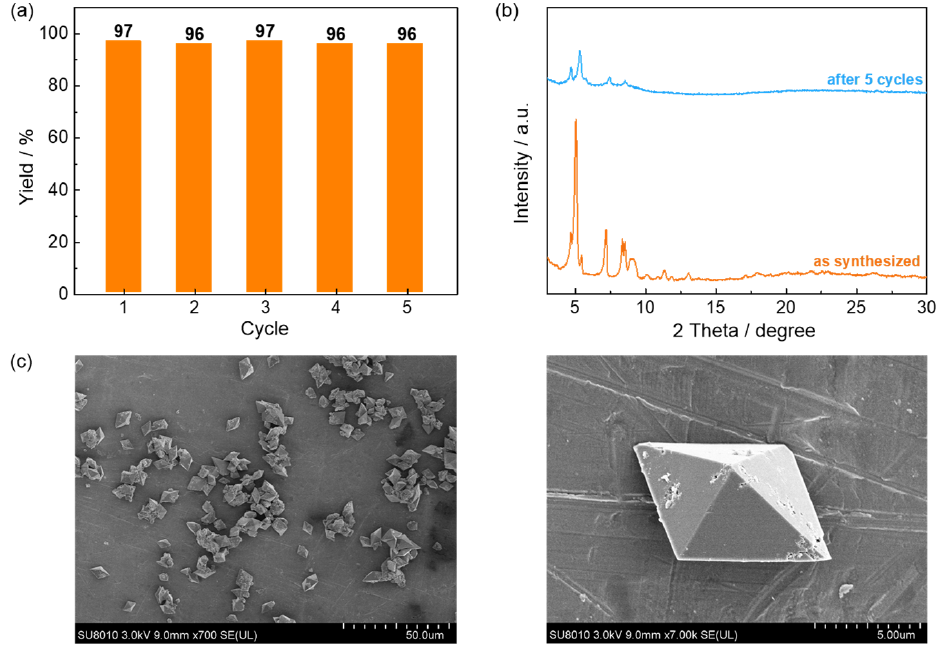
Figure 7. ( a ) The yield of methylphenyl sulfoxide in five cycles with Zr-MOF-P as photocatalyst. ( b ) PXRD patterns of Zr-MOF-P before and after five cycles. ( c ) SEM images of Zr-MOF-P after five cycles.